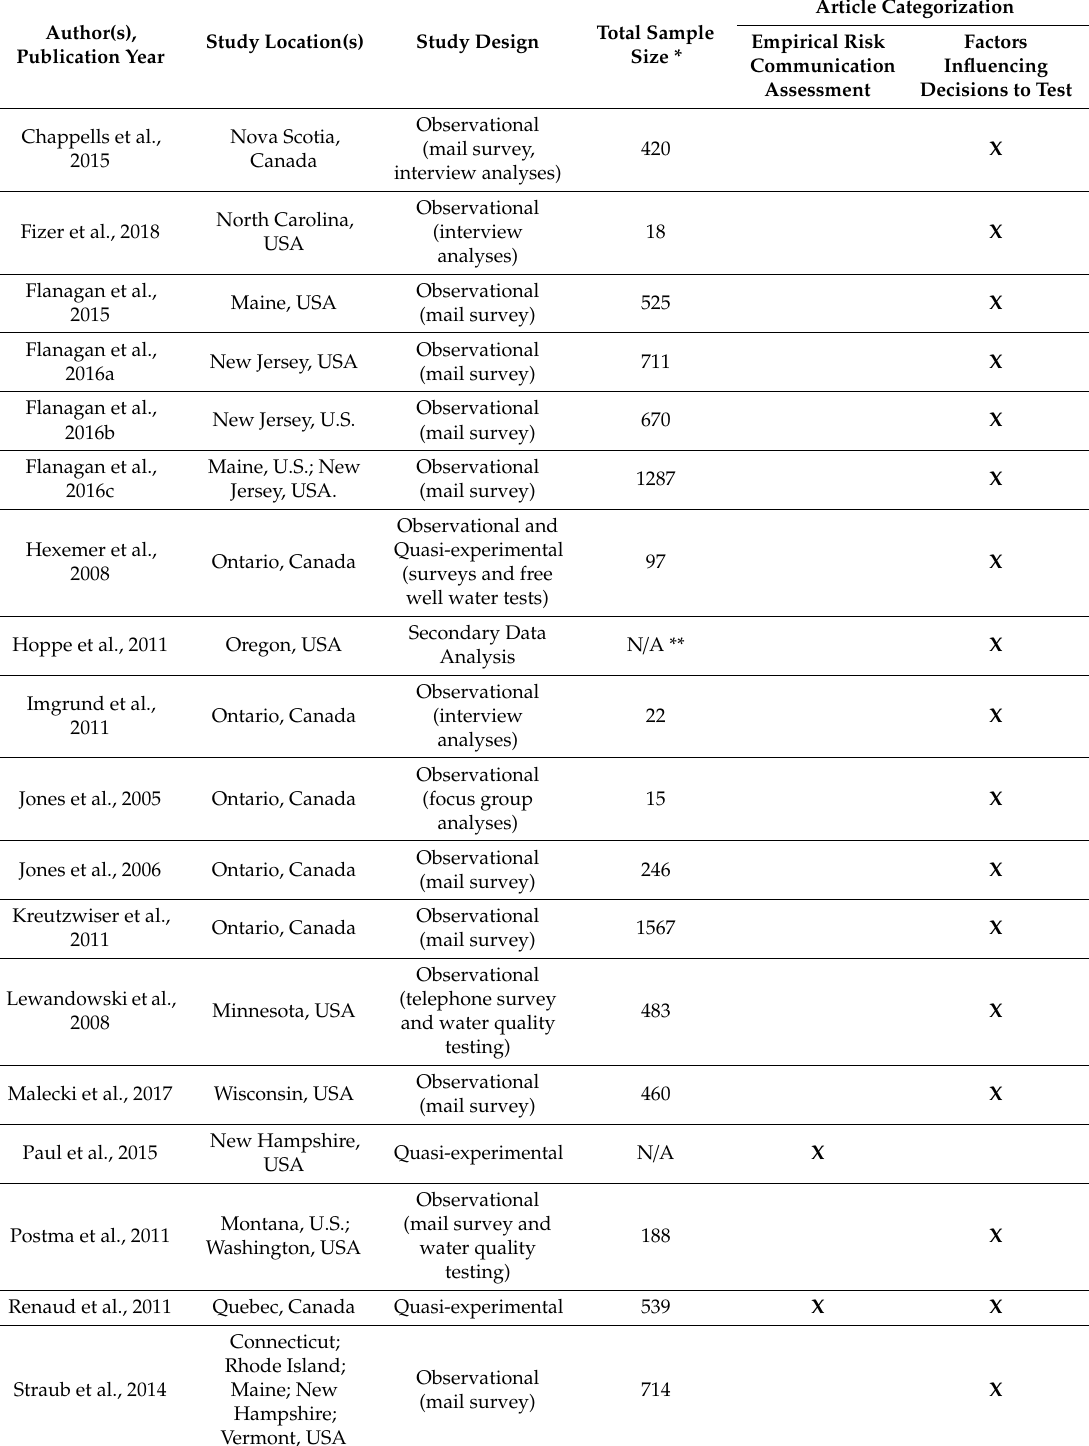
Table 3. Characteristics of the included